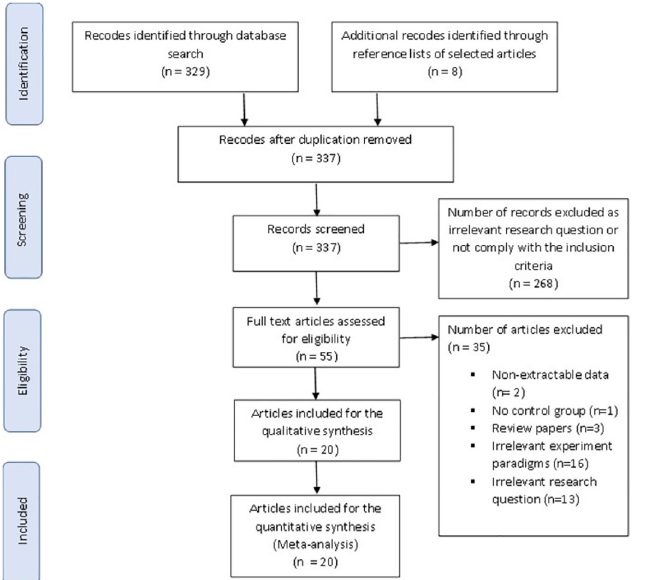
Fig 1. A schematic representation of the search and selection process for studies that were excluded and included in the present